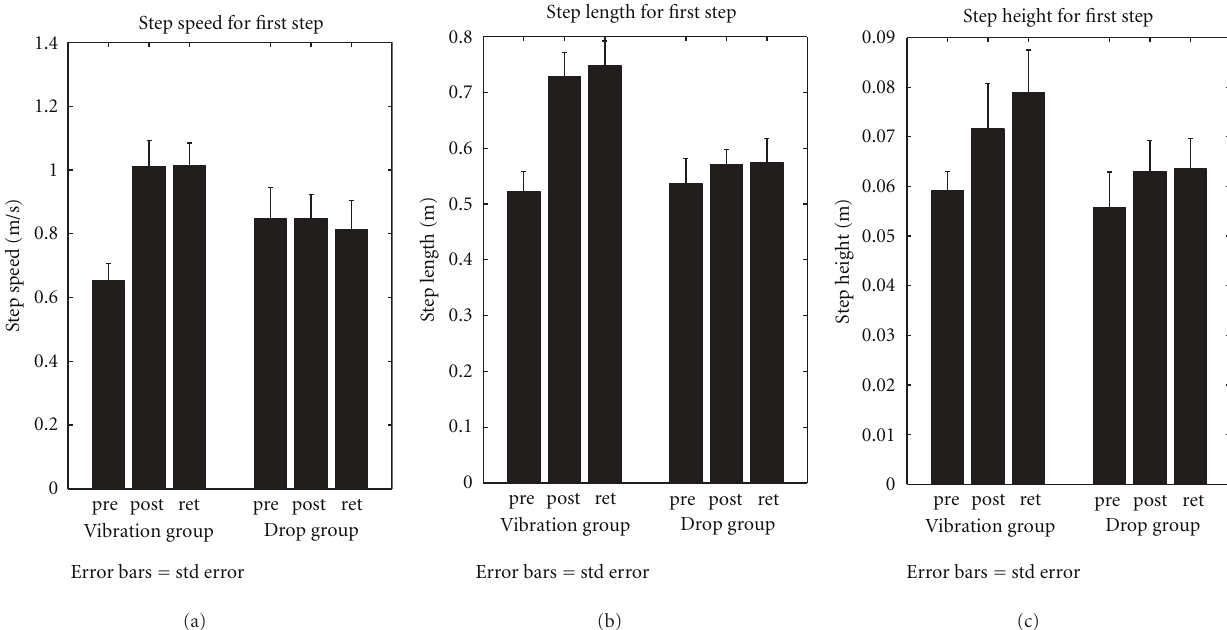
Figure 5: The group mean values plus 1 SEM for first-step (a) speed, (b) length, and (c) height measured at baseline prior to posture-assisted locomotion (PAL) training (pre), immediately after training (post), and six weeks after the completion of training (ret) PD subjects in drop assist and vibration assist training groups. Unpublished